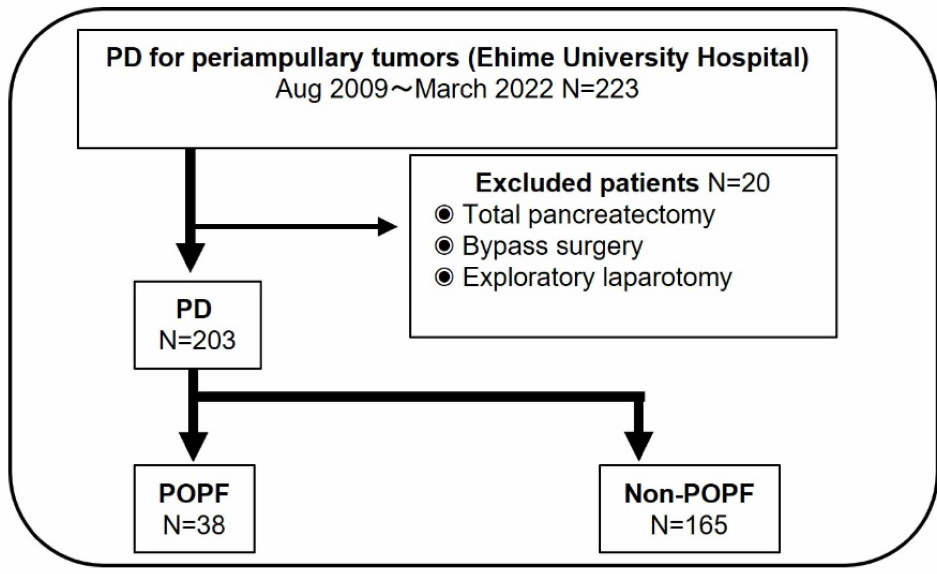
Figure 1. Study flow